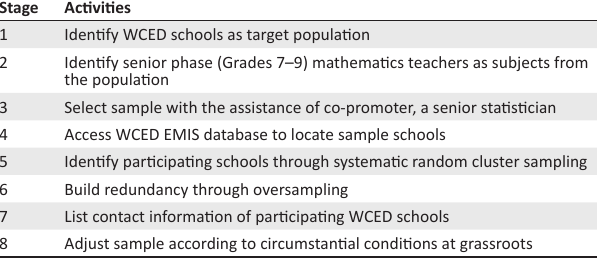
TABLE 3: Stages in sample selection.